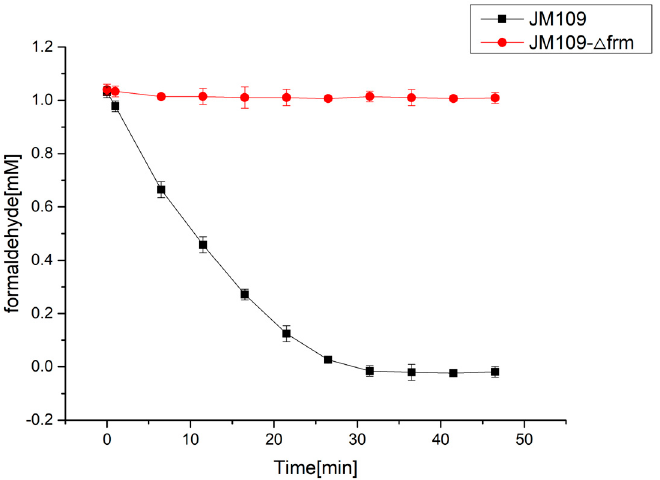
Figure 2. Formaldehyde degradation in E. coli JM109 strain (black symbols) and JM109- ∆ frm strain (red symbols). The result indicated that the deletion of frmA is important to accumulate enough formaldehyde as the substrate for RuMP pathway. All experiments were conducted in triplicate. The mean values of three biological replicates are presented, and error bars indicate standard deviations.